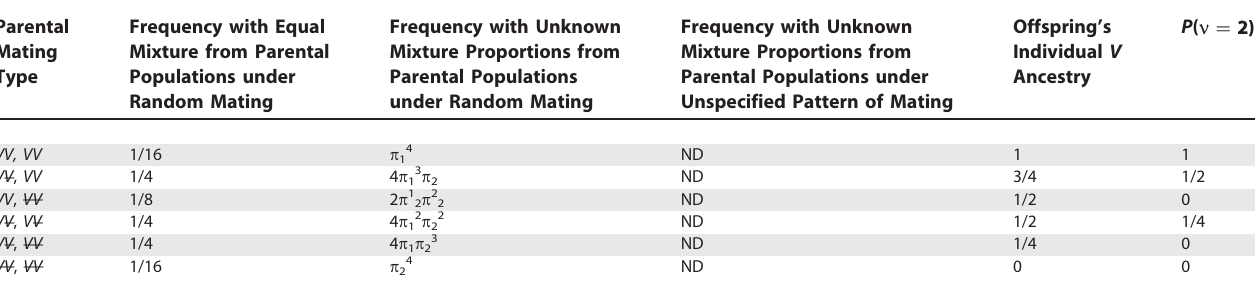
Table 1. Expected Population Resulting from Two Generations of Random Mating between Two Inbred Populations Frequency with Equal Parental Mixture from Mating Type